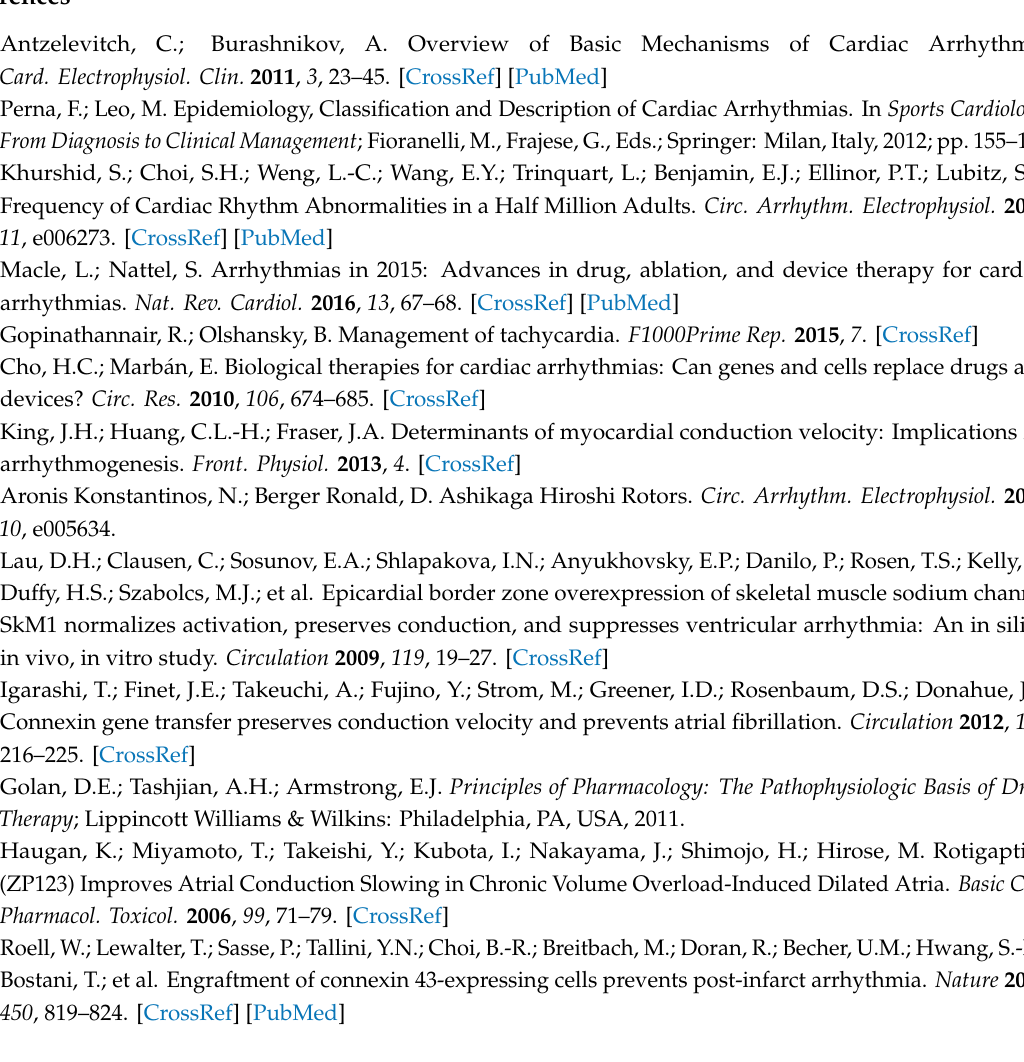
Table S1. Primers used for RT-PCR; Figure S1. Representative images of the HL-1 culture at 100% confluency on day 4 of the experiment in control and CDC-EVs groups; Video S1. Activation complexity recording in a representative example of a control culture vs. a CDC-EV treated culture; Video S2. Conduction velocity recording in a representative example of a control culture vs. a CDC-EV treated